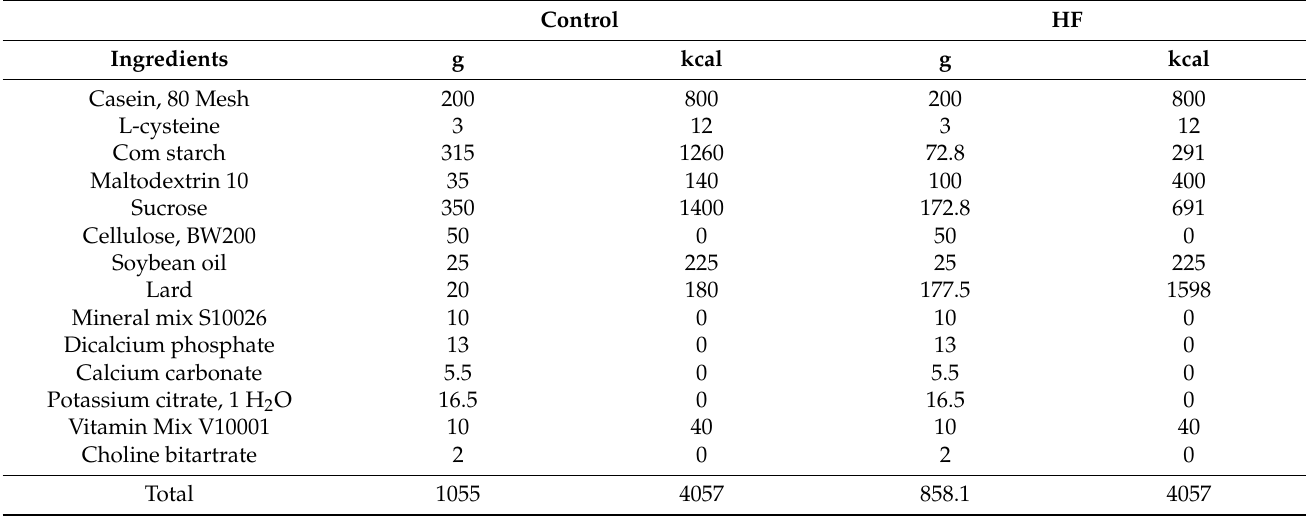
Table 1. Details of the diets. The control diet was a conventional D12450B diet. More than 20% energy added to HF